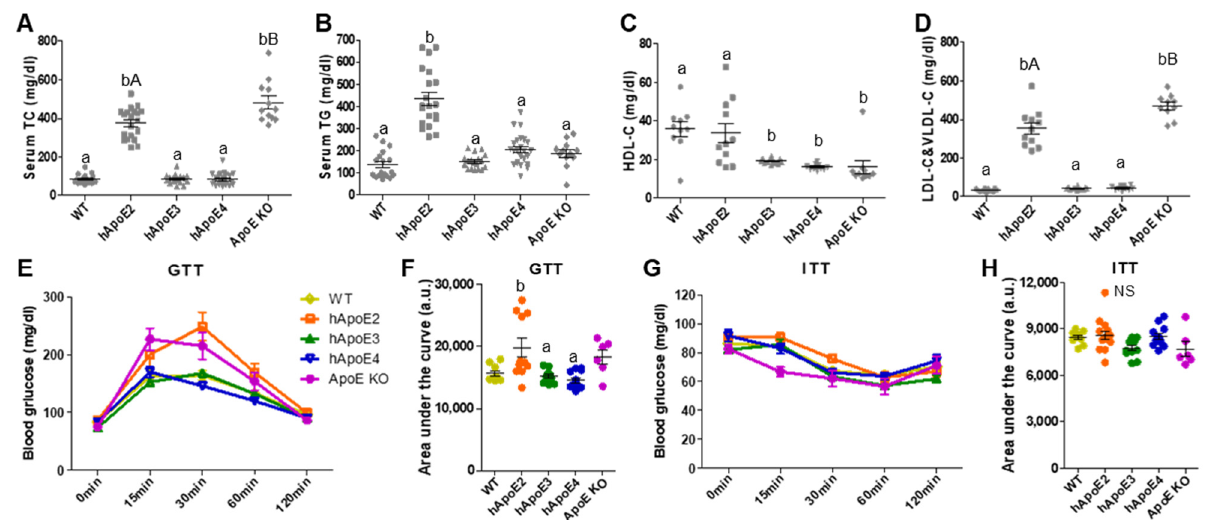
Figure 3. Metabolism sketch of WT, hApoE KI, and ApoE KO rats. ( A – D ) The levels of TC, TG, HDL-C, and LDL-C&VLDL- C in serum of each rat strain collected at age 8 weeks were detected after overnight fasting (~18 h) (TC and TG: WT n = 18, hApoE2 n = 20, hApoE3 n = 20, hApoE4 n = 23, and ApoE KO n = 12; HDL-C, and LDL-C&VLDL-C: WT n = 10, hApoE2 n = 11, hApoE3 n = 12, hApoE4 n = 10, and ApoE KO n = 10). ( E , F ) GTT with i.p. injection of 2 g glucose per kg of bodyweight was performed on rats at age 12 to 14 weeks after overnight fasting (WT n = 9, hApoE2 n = 11, hApoE3 n = 11, hApoE4 n = 12, and ApoE KO n = 6). ( G , H ) ITT with i.p. injection of 0.75 U insulin per kg of bodyweight was performed on rats at the same age after 6-h fasting. (One-way ANOVA followed by a Tukey post hoc test. a vs. b, A vs. B, p < 0.05, NS, no significant difference).